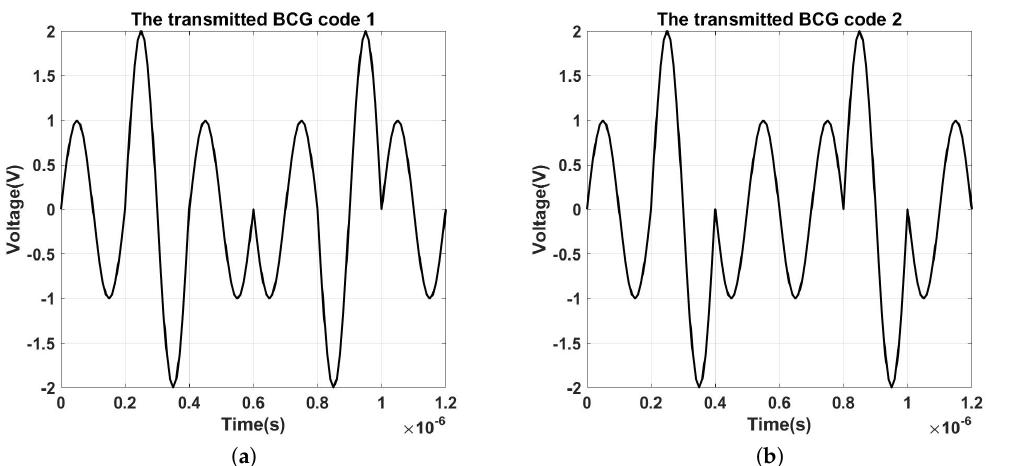
Figure 6. The transmitted B3G4 code pair in the Filed II simulation. ( a ) The first transmitted BCG code ( b ) The second transmitted BCG